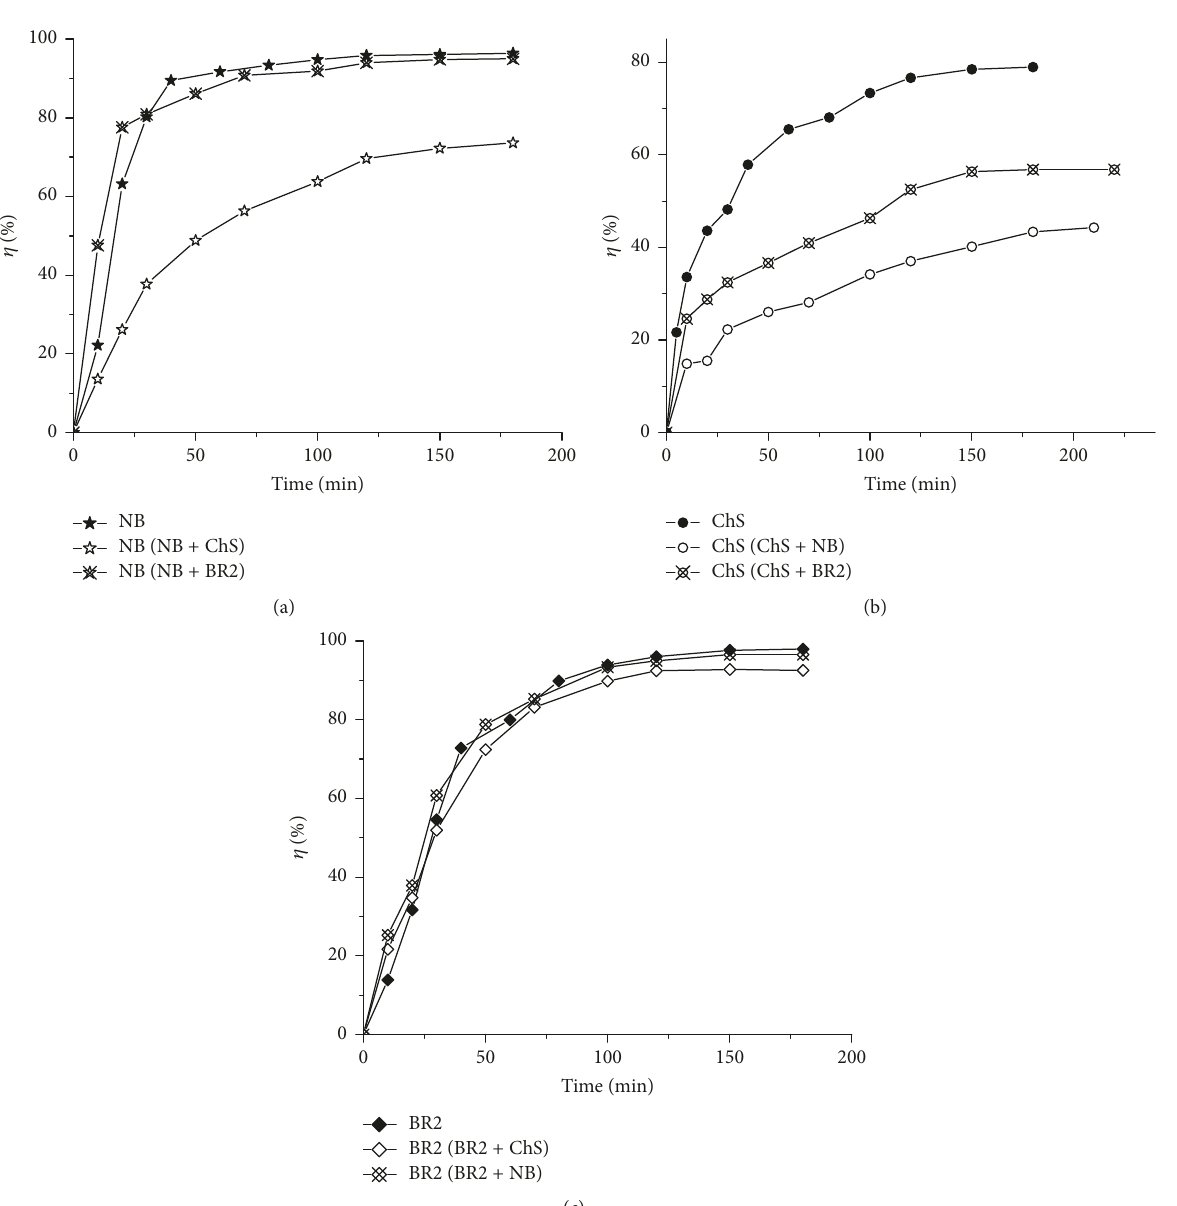
Figure 10: The kinetics of competitive adsorption of NB, ChS, and BR2 in single- and binary-solute systems (100mg/L, adsorbent 2g/L, 25 ∘ C, pH 7.4 for NB, 7.1 for ChS, and 6.7 for